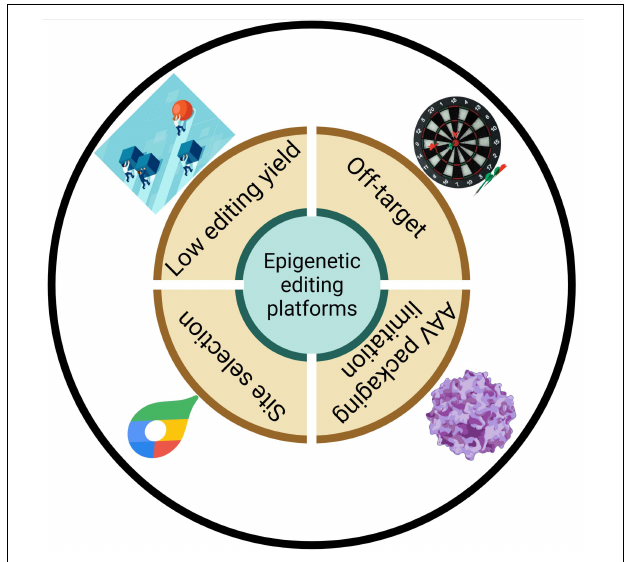
FIGURE 3 | Schematic diagram of potential limitations of epigenetic editing